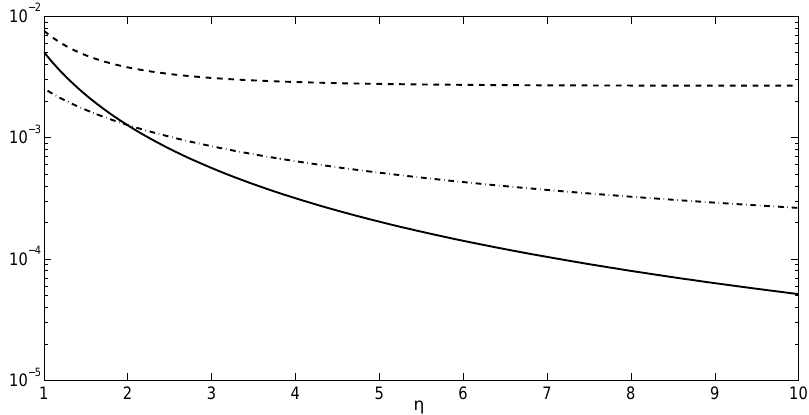
− σ 2 | (dashed line) and | (cid:101) µ − µ | (dashed-dotted V V